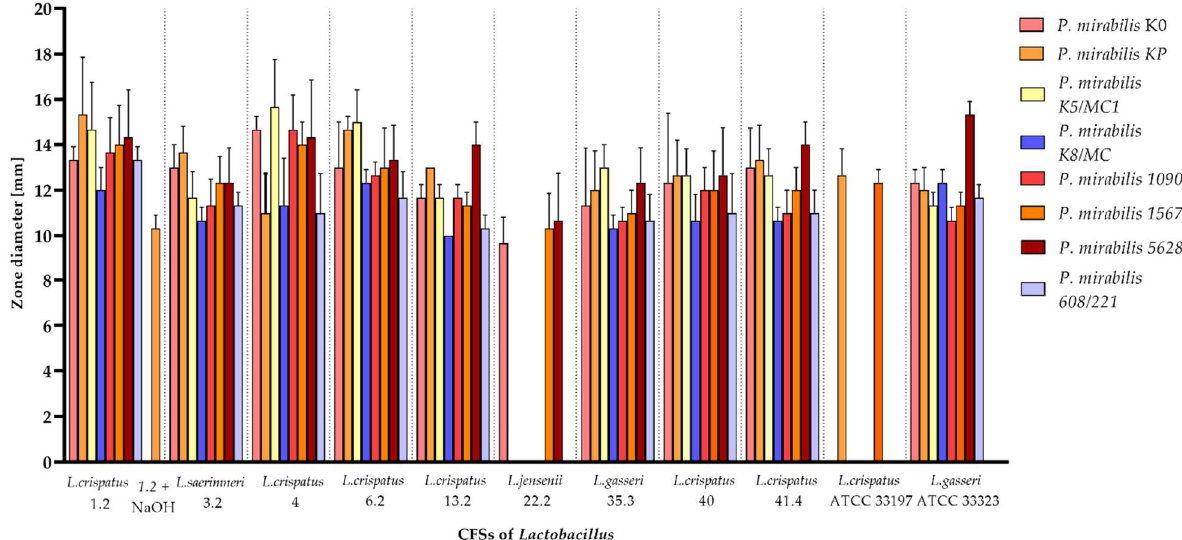
Figure 1. Zone of inhibition of Lactobacillus strains against P. mirabilis according to well diffusion assay. The data of CFSs treated with NaOH (excluding L. crispatus 1.2) are not shown due to the lack of Proteus growth inhibition. The results are presented as the mean ± standard deviation (SD) of three experiments. All the results are statistically significant ( p < 0.05), according to U Mann–Whitney test.